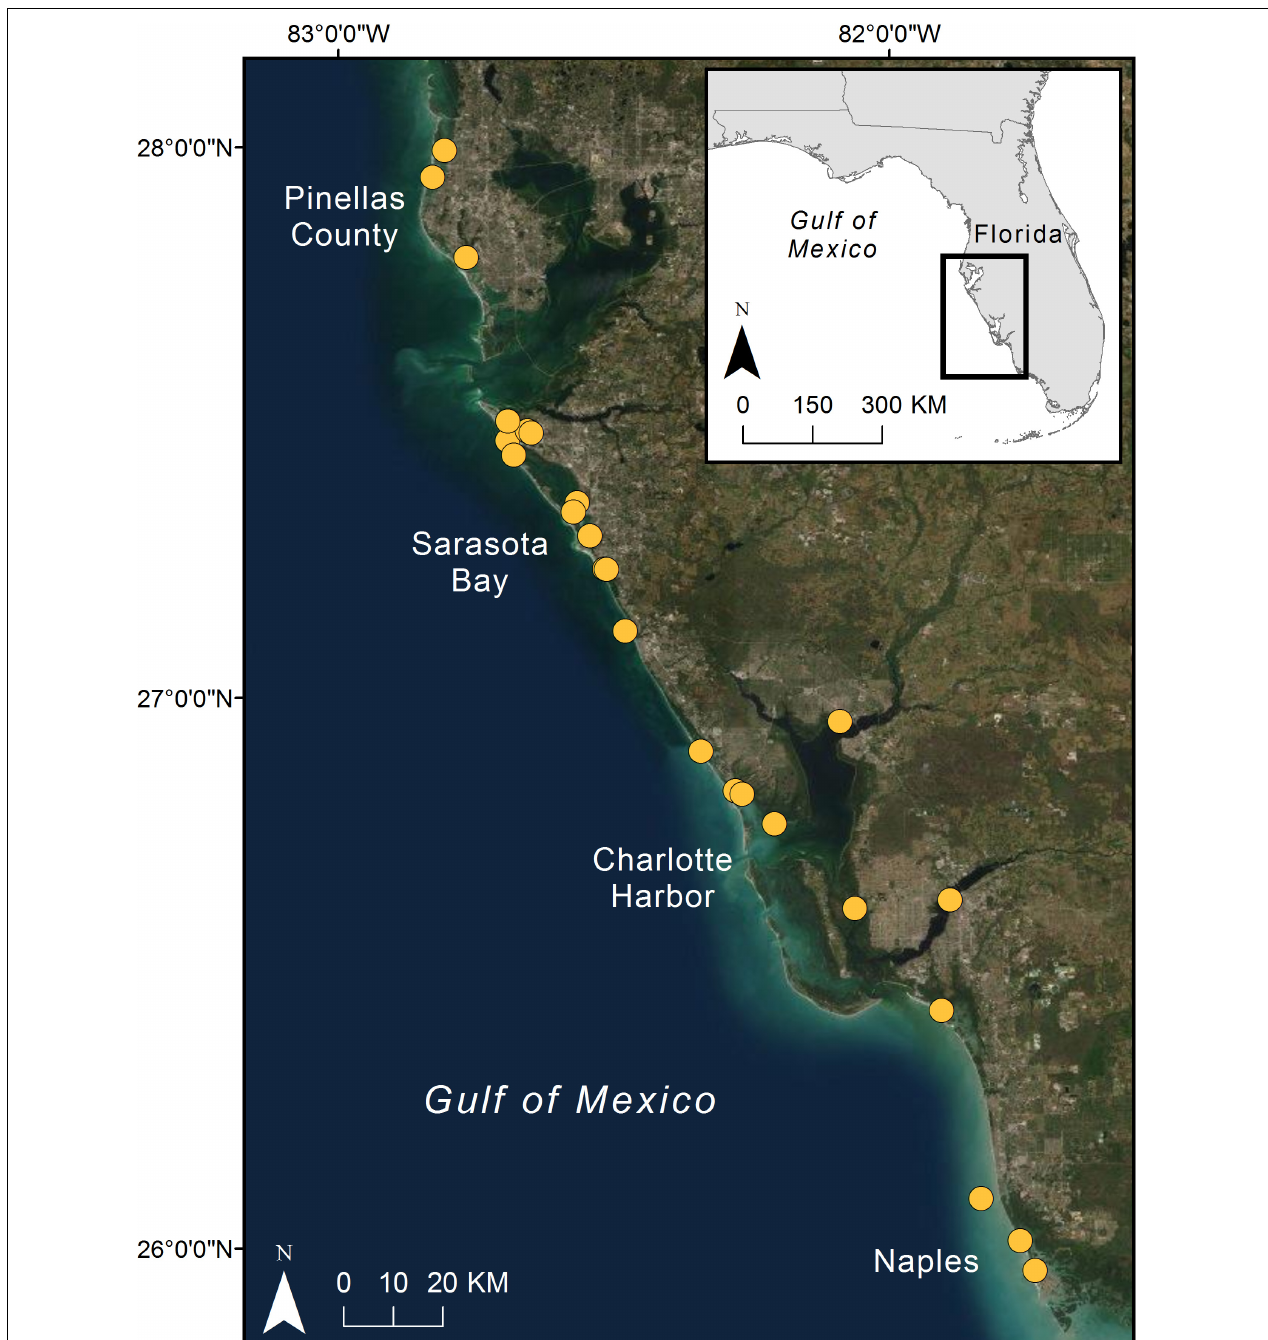
FIGURE 1 | Map of the overall study area showing rescue locations for pre-stranding intervention cases in Southwest